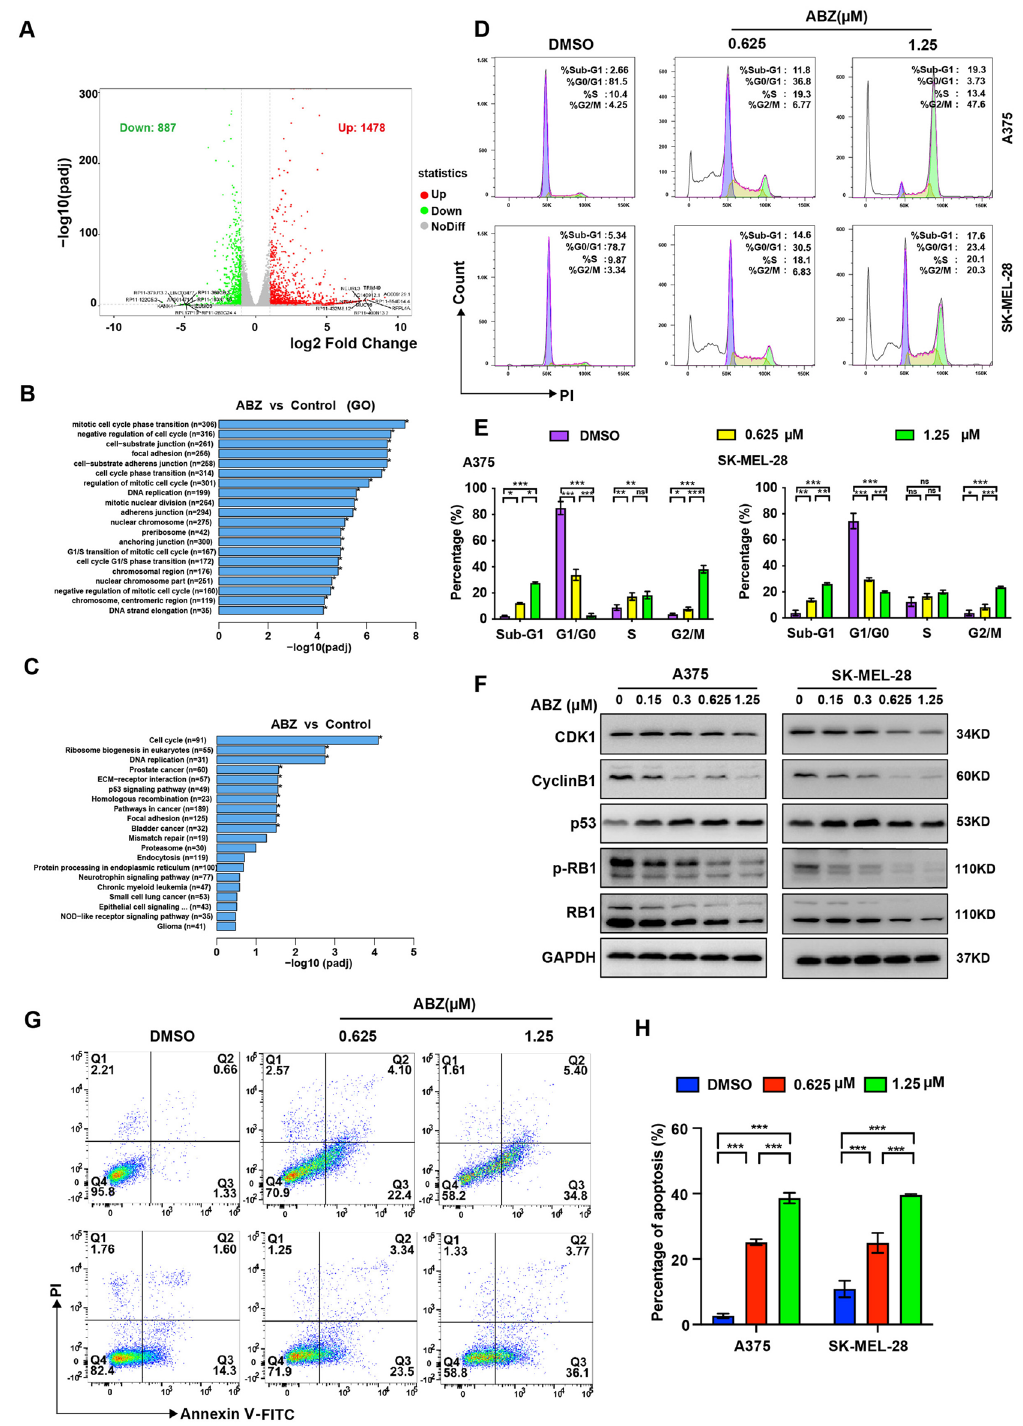
Figure 2. ABZ arrested the melanoma cell cycle at the G2/M phase and induced cell apoptosis. ( A ) Summary of the distribution of differentially expressed genes identified from RNA sequencing data generated from A375 cells with or without ABZ treatment. The average log CPM (count per million) represented the gene expression level. The color represents differentially expressed genes (fold change > 1.5, FDR < 0.05; red: upregulation, green: downregulation, gray: nonsignificant change). B-C. Top enriched GO ( B ) and KEGG ( C ) biological process pathways for genes upregulated or downregulated in A375 cells treated with ABZ. D-E. Representative image ( D ) and quantification ( E ) of flow cytometry analysis of the cell cycle in A375 and SK-MEL-28 cells after treatment with the indicated doses of ABZ. Bar graphs show the quantified results of three independent experiments and are shown as the means ± SD, NS p > 0.05, * p < 0.05, ** p < 0.01, *** p < 0.001. ( F ) Representative image (full-length gels were presented in Supplementary Figure 1B) of western blot analysis of CDK1, Cyclin B1, p53, p-RB1 and RB1 in A375 and SK-MEL-28 cells after treatment with the indicated doses of ABZ. GAPDH was used as the loading control. Representative image ( G ) and quantification ( H ) of flow cytometry analysis of apoptosis in A375 and SK-MEL-28 cells after treatment with the indicated doses of ABZ. Bar graphs show the quantified results of three independent experiments and are shown as the means ± SD, *** p <